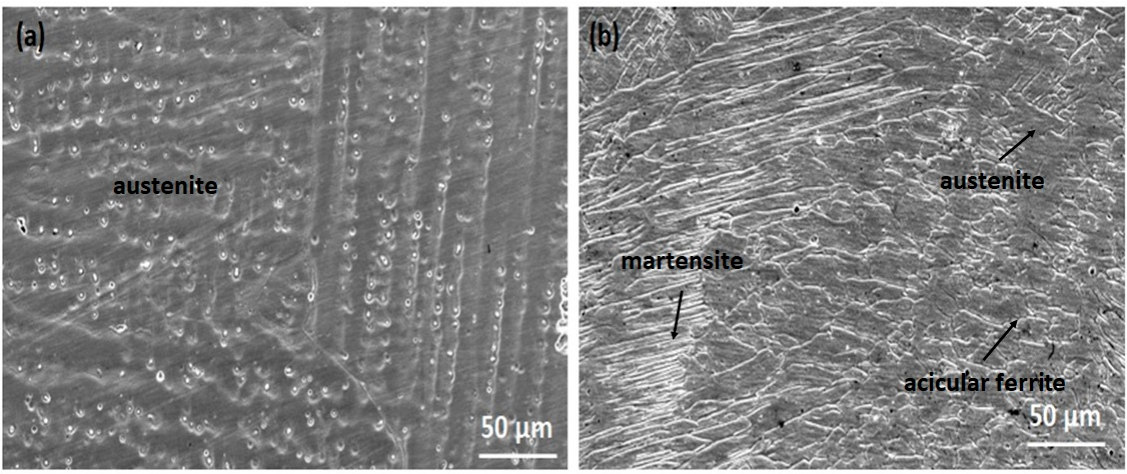
Figure 7. SEM Micrograph of weld zone of ( a ) 310 ( b ) 410 filler. Table 4. Microstructural details of welding.